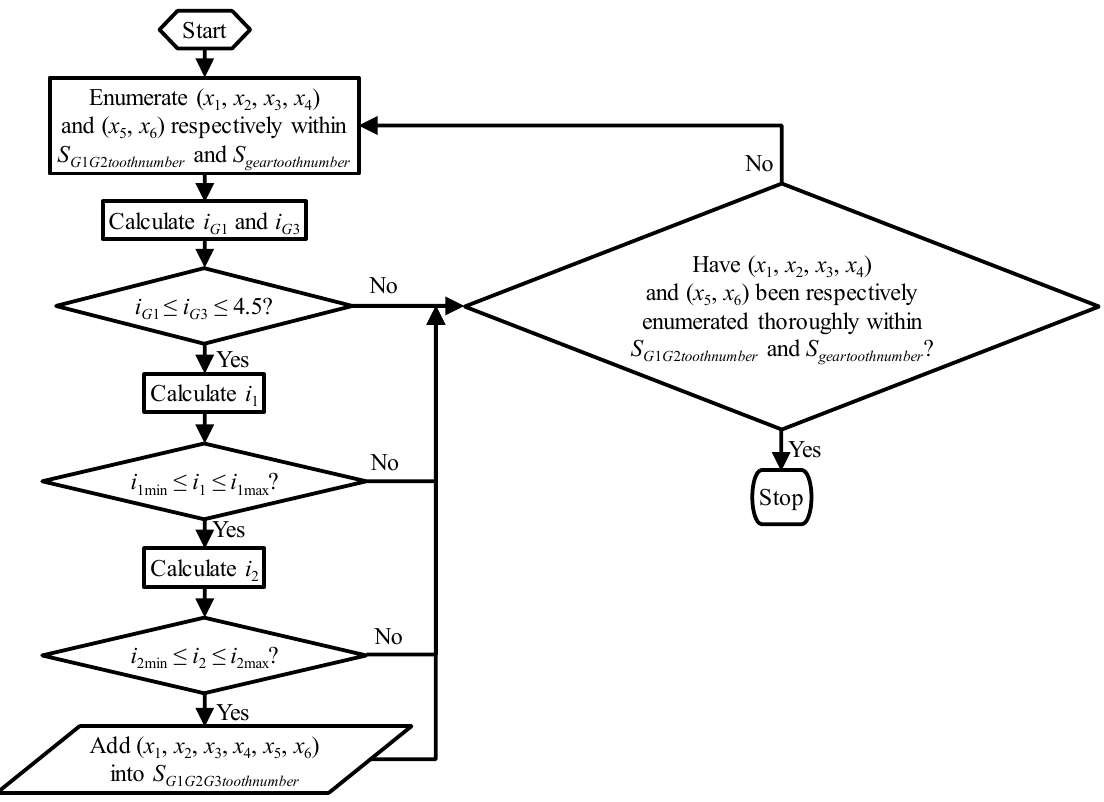
Figure 5. Scheme of the enumeration for the tooth numbers of G1, G2 and G3.